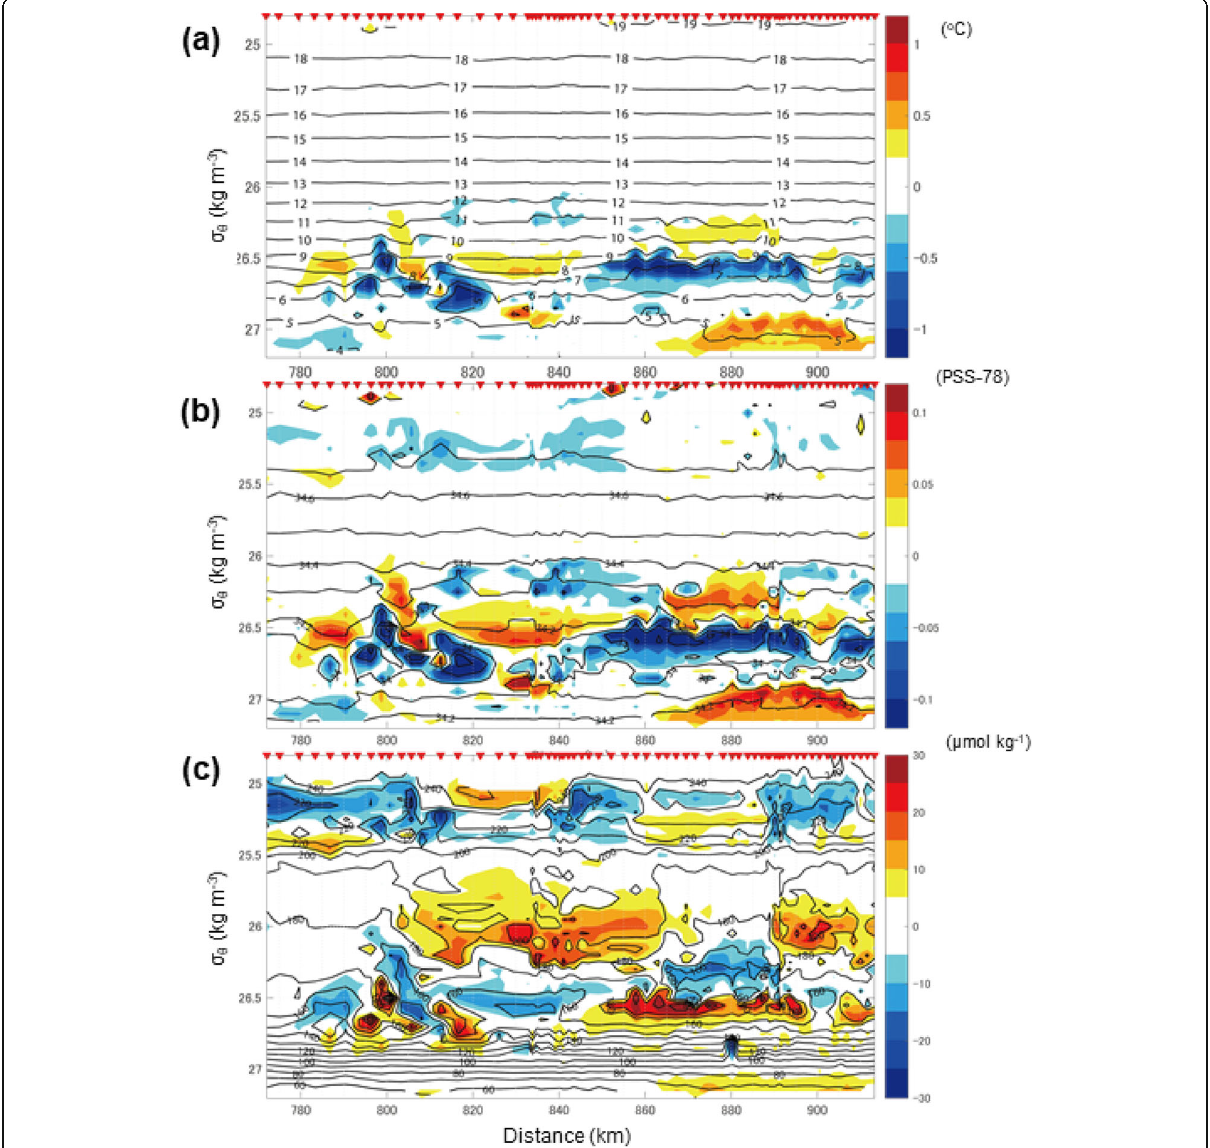
Fig. 4 Time series of a temperature (°C), b salinity (PSS-78), and c DO anomaly ( μ mol kg − 1 ; contours) on isopycnal surfaces during Apr. 28 – May 13, with salinity and DO anomalies (color) calculated from the average profiles except for Apr. 28 – May 13. Contour intervals of temperature, salinity, and DO are 1 °C, 0.1, and 20 μ mol kg − 1 , respectively. Values on isopycnal surfaces are interpolated every 0.01 kg m − 3 from the individual profiles of the Seaglider data. Linear trends calculated from the whole observation period are removed for each parameter. x -axis represents the cumulative distance based on the launching